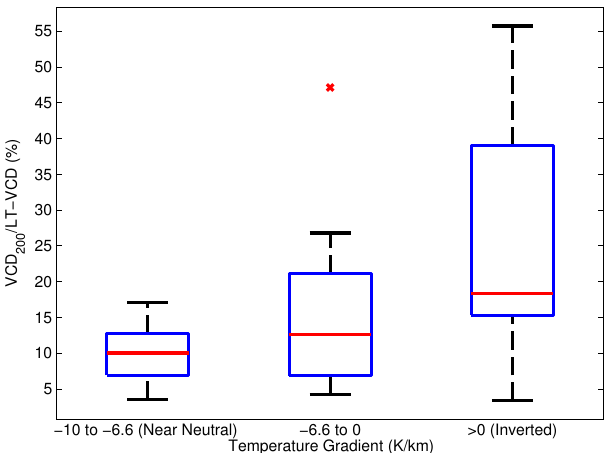
Figure 9. The relationship between daily estimated temperature gradients vs. the average percentage of BrO observed in the near- surface layer during that day is shown here using a box and whisker plot. The data are split such that each bin comprises ≈ 20 days worth of data. The red lines show the median value for each bin, while the blue box encloses the 25–75th percentiles and the whiskers show the full range of data excluding outliers ( × ). Out- liers are points that are outside 3 σ for the corresponding